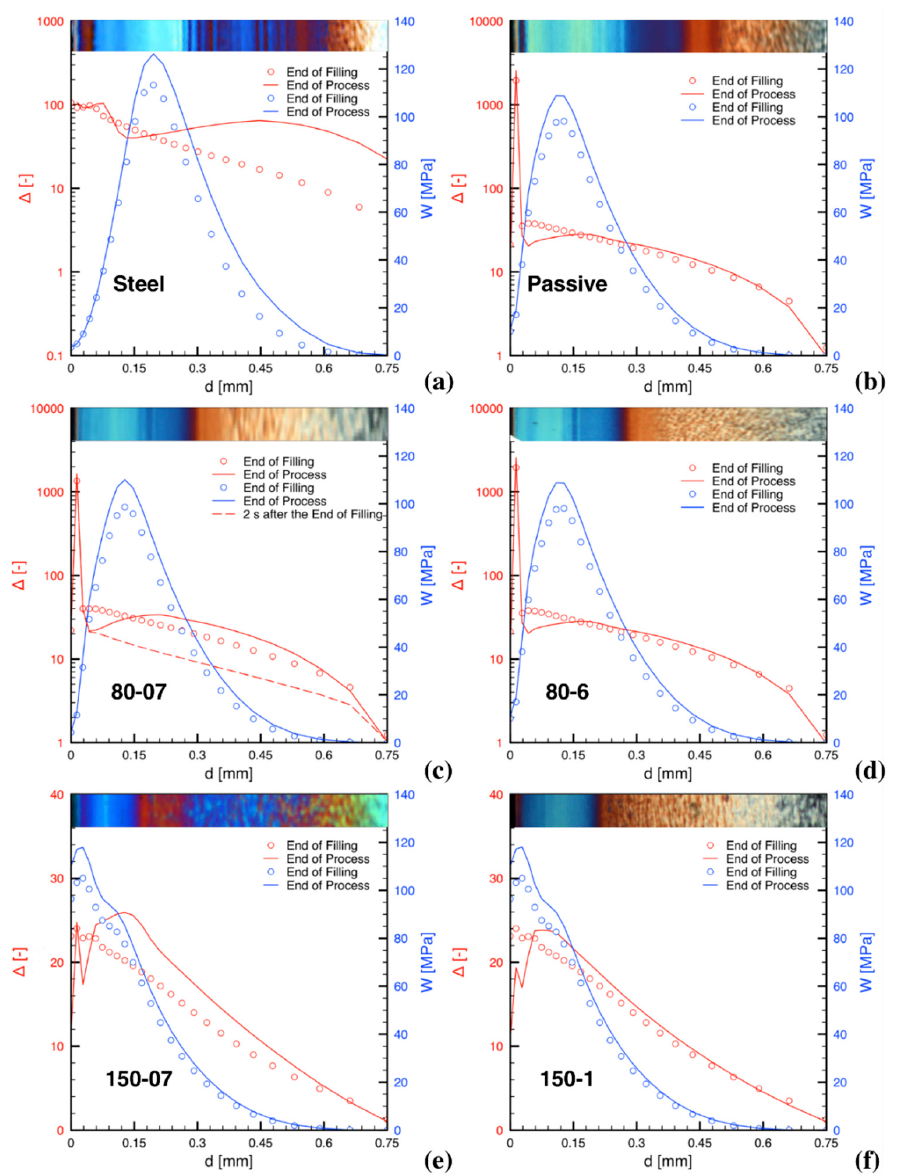
Figure 3. Molecular stretch distribution (namely Δ in red) and integral of mechanical work (namely W in blue) as calculated by the simulation for tests with different T cs and heating times: Steel ( a ); Passive ( b ); 80 °C and 0.7 s ( c ); 80 °C and 6 s ( d ); 150 °C and 0.7 s ( e ); 150 °C and 1.3 s ( f ). Cross section distributions in position P2 at the end of filling (symbols) and at the end of the process (full lines). The Δ distribution 2 s after the end of filling (red dashed line) is also reported for the test 80-07 (c). A comparison of Δ and W distributions for the Steel and Passive tests shows that main differences concerning the plot of Δ can be ascribed to the higher cooling rate of the Steel test with